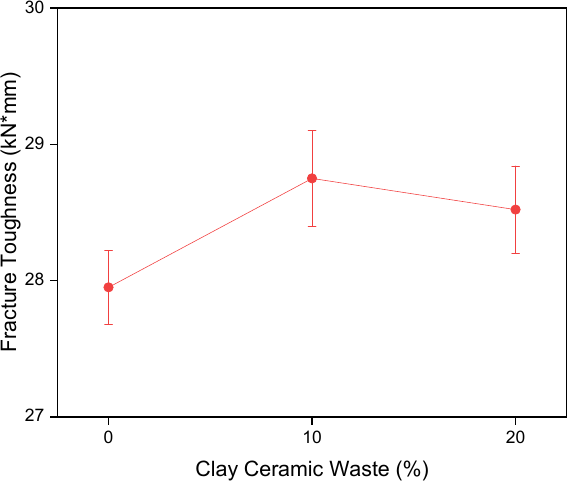
Figure 4. Fracture Figure 4. Fracture toughness.